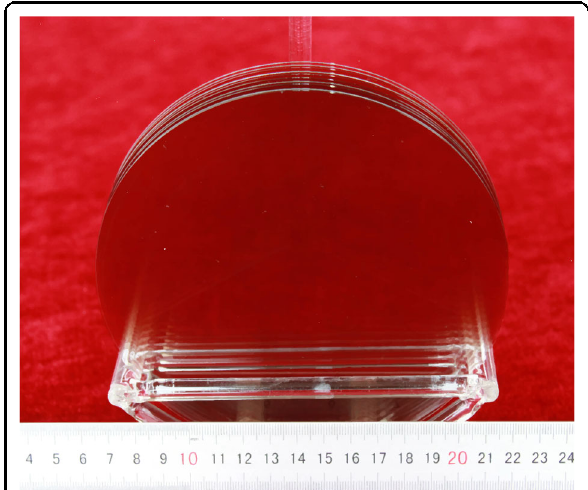
Fig. 9 The FWHM distribution of 6-inch HPSI SiC substrate